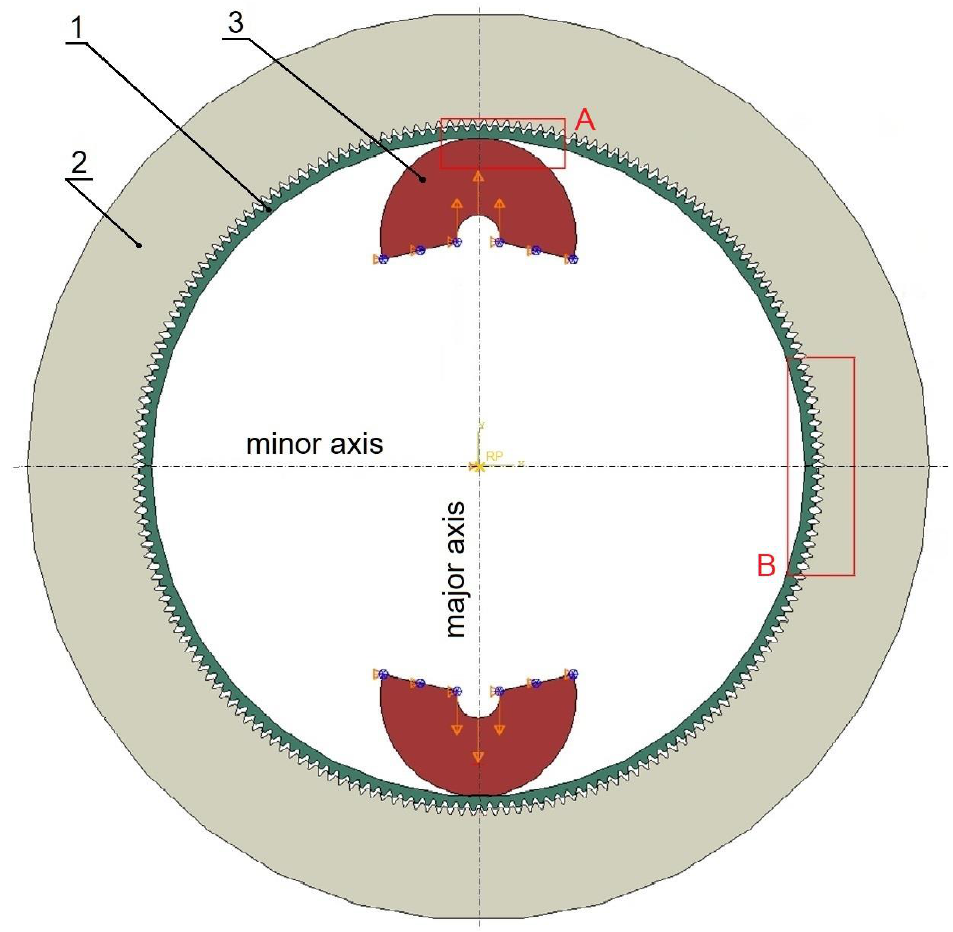
Figure 8. Numerical model of harmonic hermetic drive with double-roller generator: 1—flexspline, 2—circular spline, 3—double-roller generator.